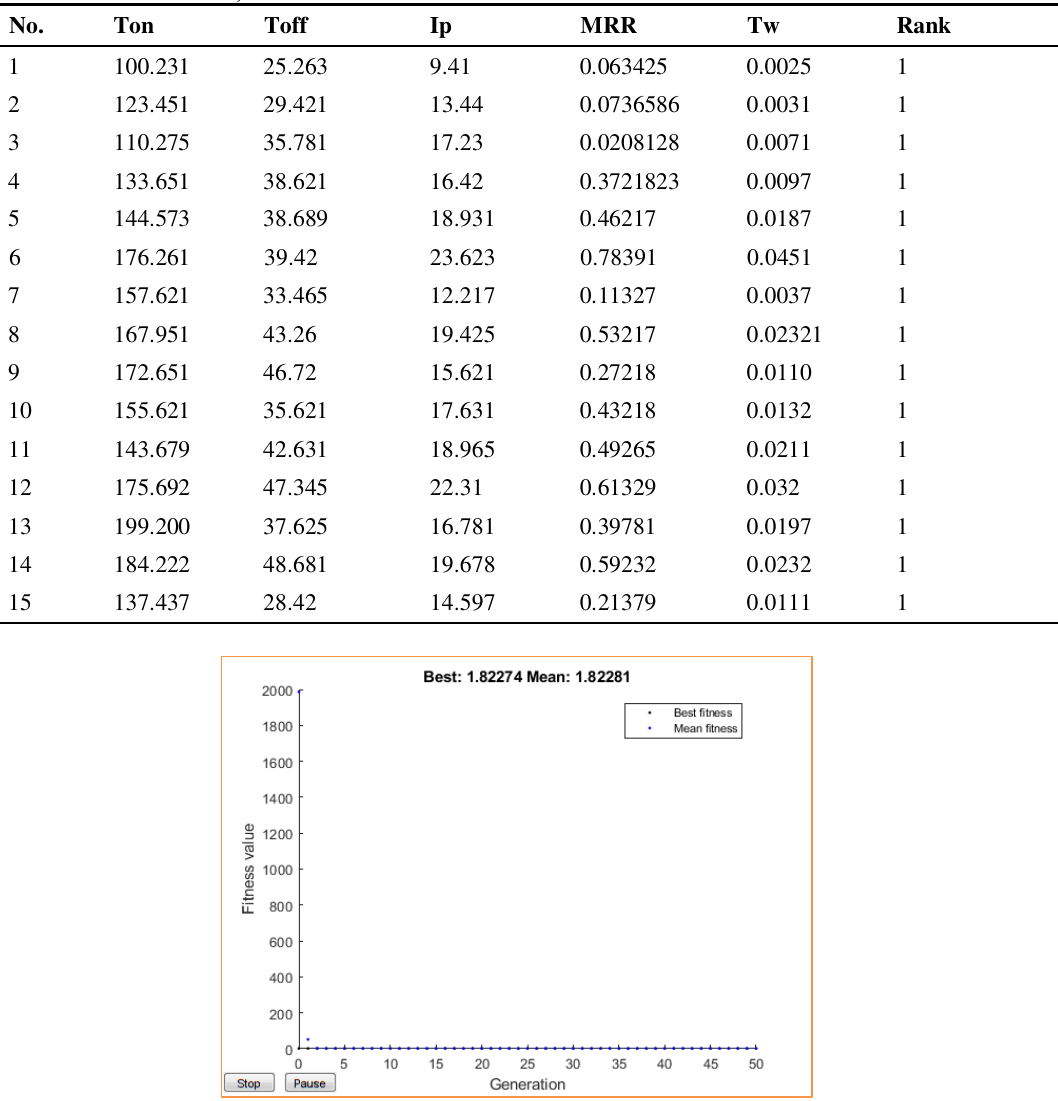
Fig. 5. The implemented data on